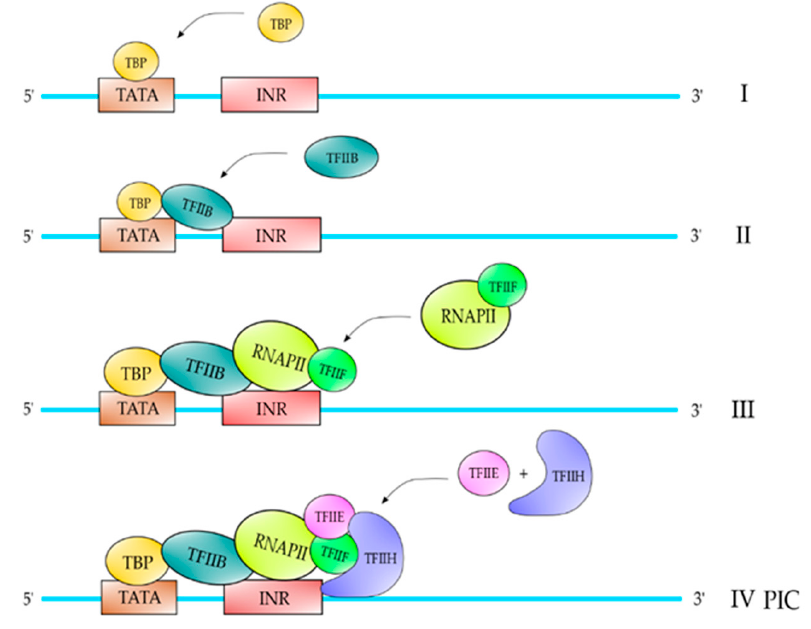
Figure 2. PIC formation on TATA-containing promoters. The first step of PIC formation on this kind of promoters is the binding of TBP to the TATA element (I), which follows the binding of TFIIB through interactions with TBP and the promoter near to the transcription start site (II). After the binding of TFIIB, the complex RNAPII-TFIIF is assembled into the complex (III), which follows the binding of TFIIE and TFIIH to form a PIC on the promoter (IV). Only the top strand of the promoter is shown in the figure for didactic purposes, but the PIC is formed on the double stranded promoter. This is also valid for Figures 3 and 4.